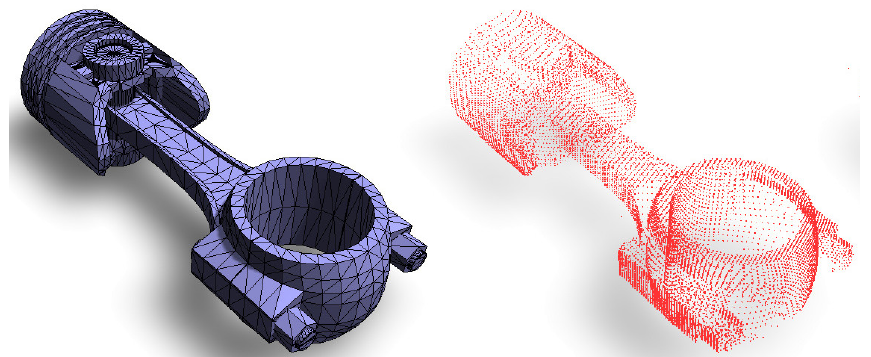
Figure 7. Standard Triangle Language (STL) model of a mechanical part and the corresponding virtual